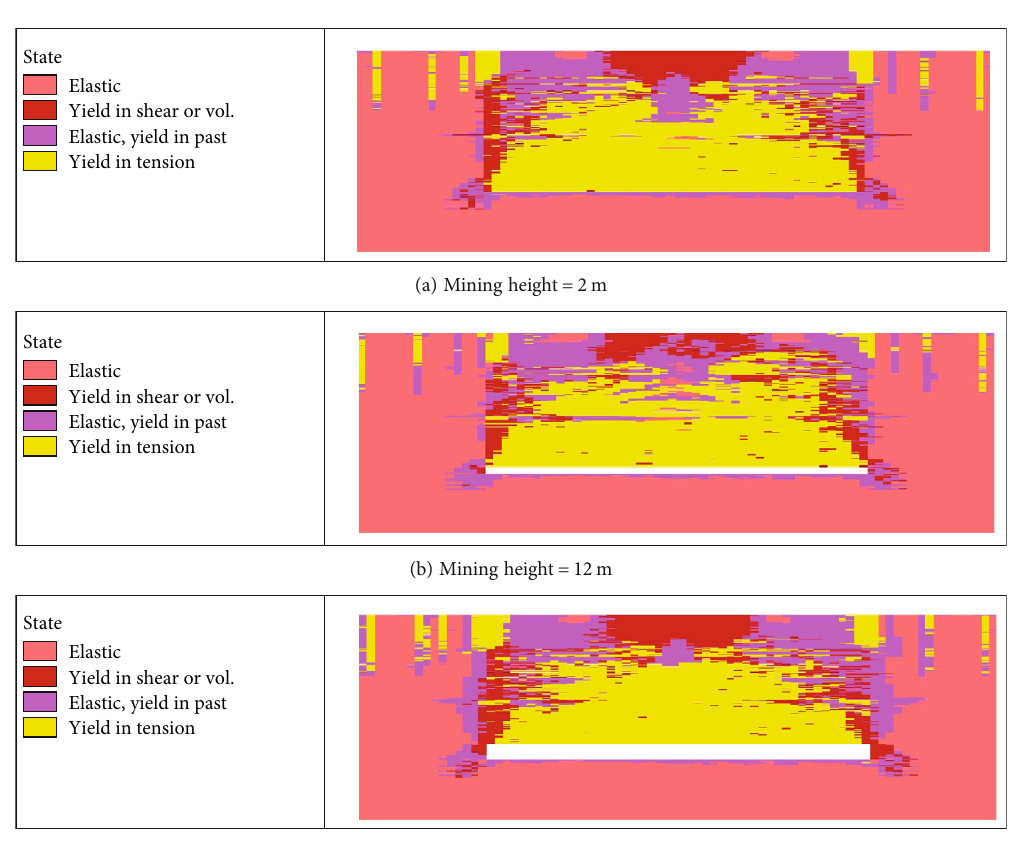
Figure 7: Plasticity diagram for fl oor failure of working face.